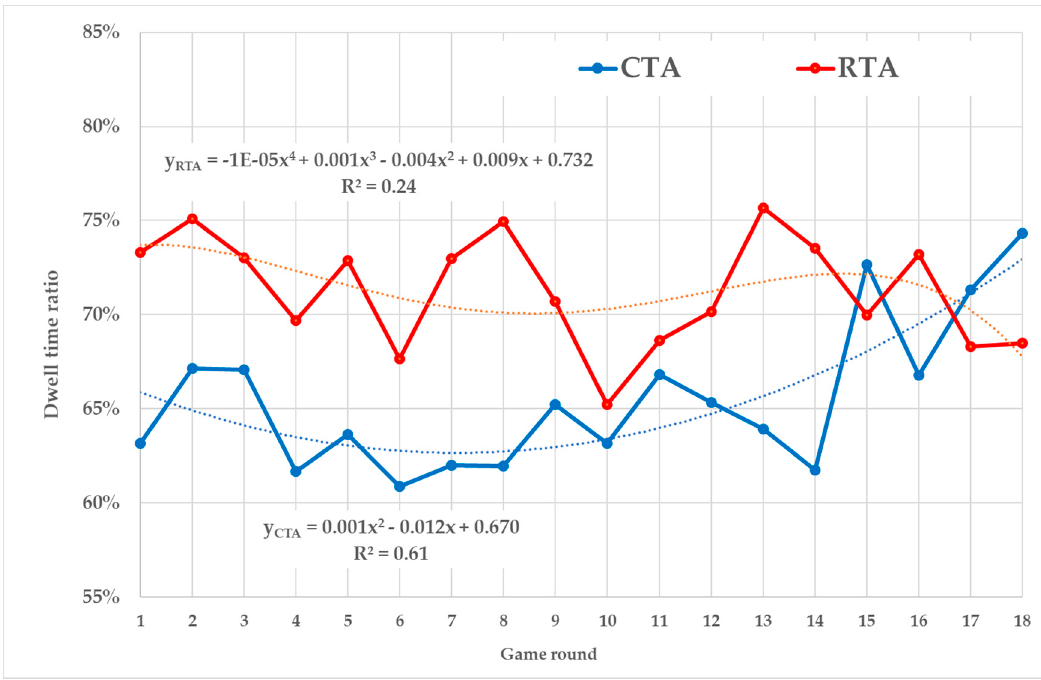
Figure 5. Dwell time ratio.